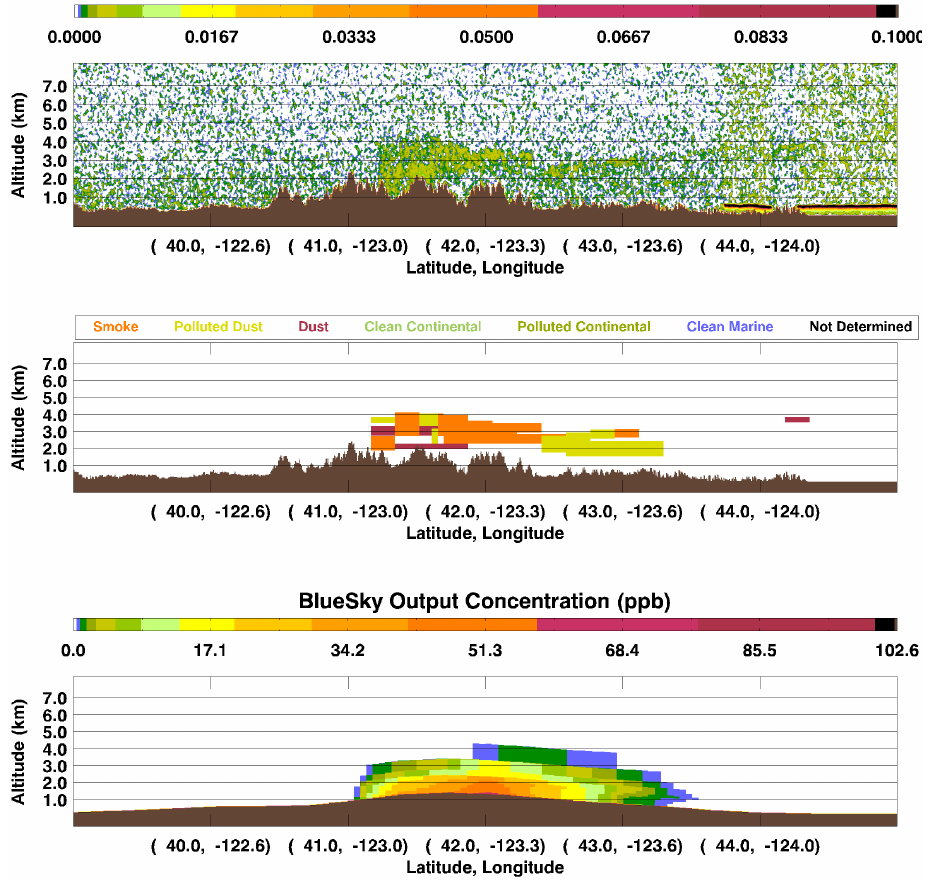
concentrations from the 2.5